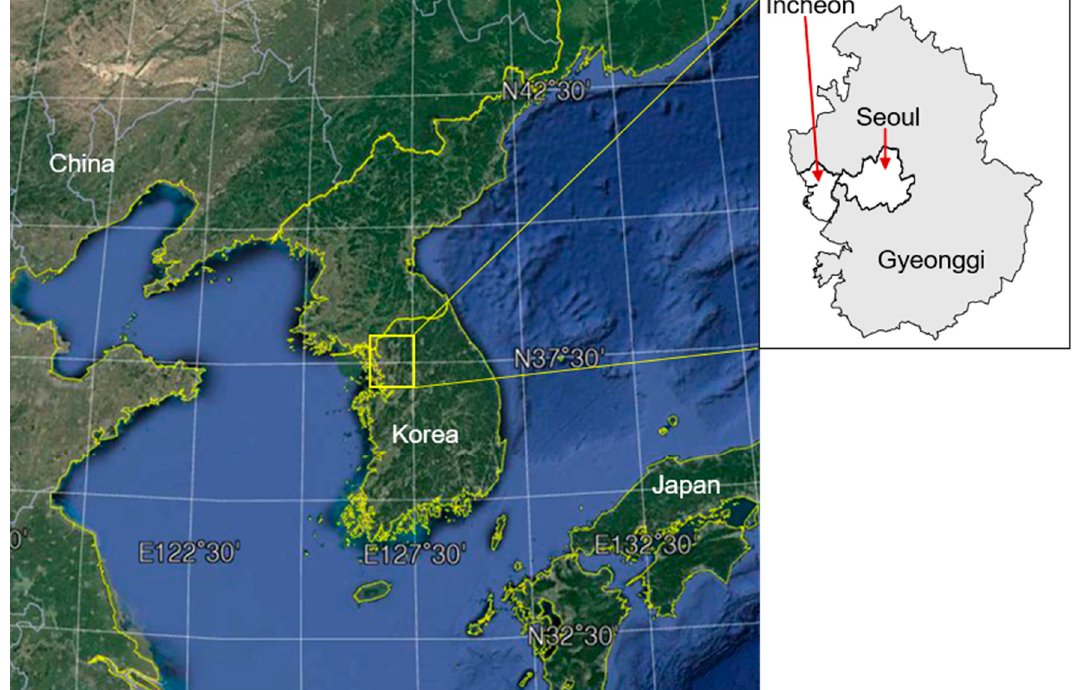
Figure 1. Locations of Seoul metropolitan area (SMA; yellow box in left figure), including Seoul proper, Incheon, and Gyeonggi (right panel). The background map was obtained from © Google